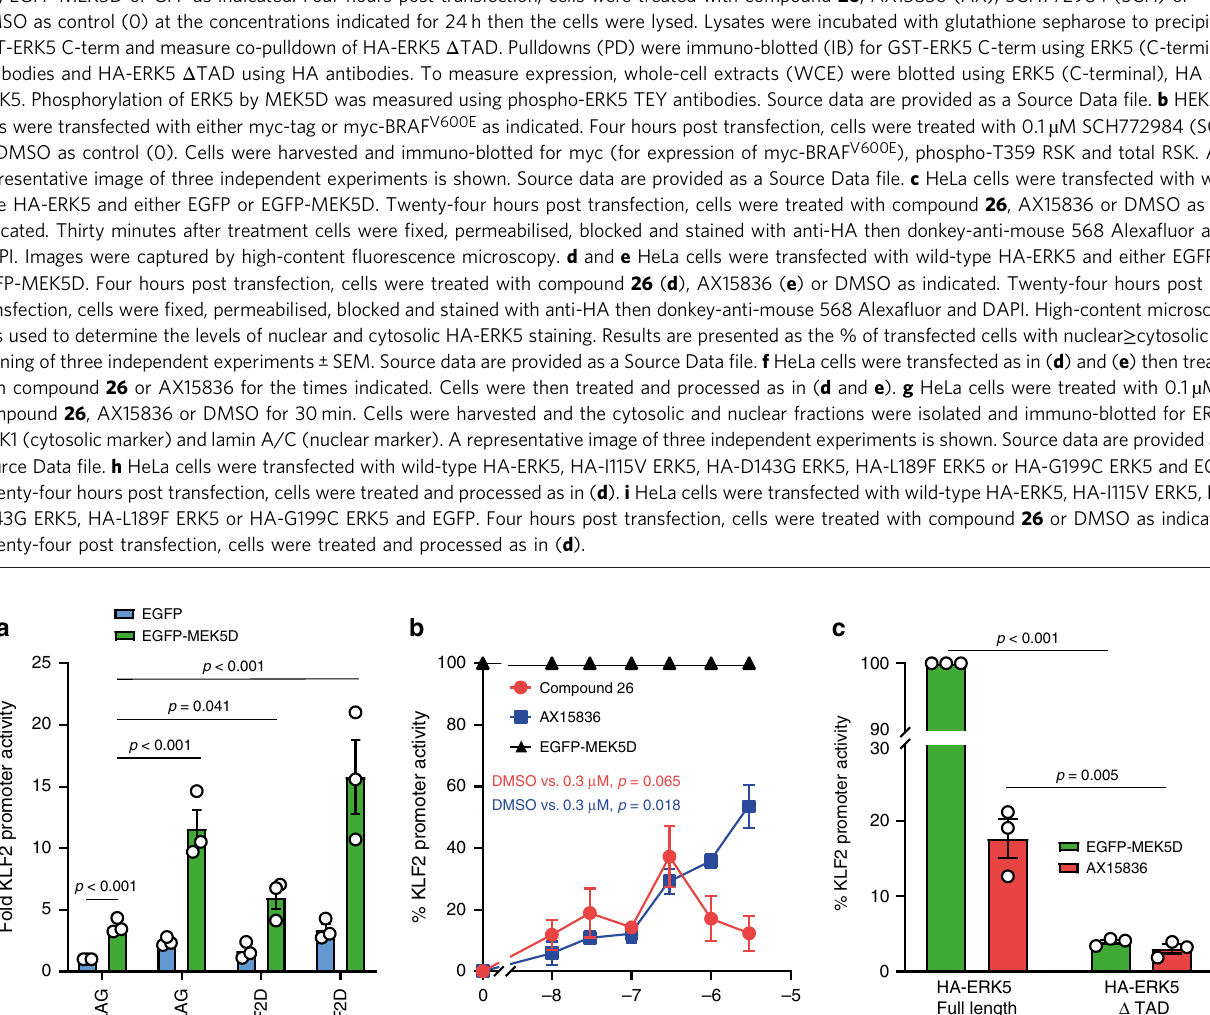
Fig. 5 Compound 26 and AX15836 promote ERK5 nuclear localisation. a HEK293 cells were transfected with GST-ERK5 C-term, HA-ERK5 Δ TAD, GST, HA, EGFP-MEK5D or GFP as indicated. Four hours post transfection, cells were treated with compound 26 , AX15836 (AX), SCH772984 (SCH) or DMSO as control (0) at the concentrations indicated for 24h then the cells were lysed. Lysates were incubated with glutathione sepharose to precipitate